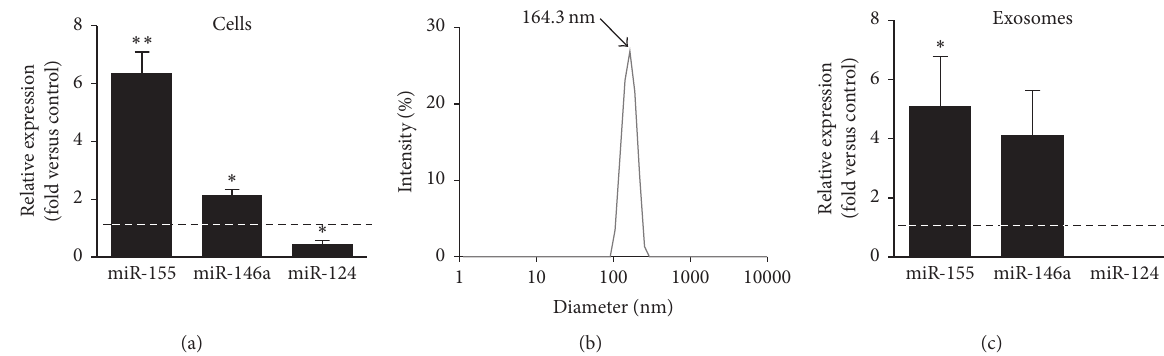
Figure 7: M1 polarized N9 microglia display upregulated levels of miR-155 and miR-146a, as well as downregulated miR-124, which are recapitulated in cell-derived exosomes. N9 cells were collected after incubation with lipopolysaccharide (LPS) and miR-155, miR-146a, and miR-124 expression were evaluated by qRT-PCR, both in cells (a) and in exosomes (c). Results are mean ± s.e.m. from five independent experiments. Comparisons between LPS-treated N9 cells and nontreated cells (control) were made via two-tailed Student’s 𝑡 -test. ∗ 𝑝 < 0.05 and ∗∗ 𝑝 < 0.01 versus nontreated cells (control). Vesicles isolated from the extracellular media of N9 cells were characterized in terms of their size by dynamic light scattering